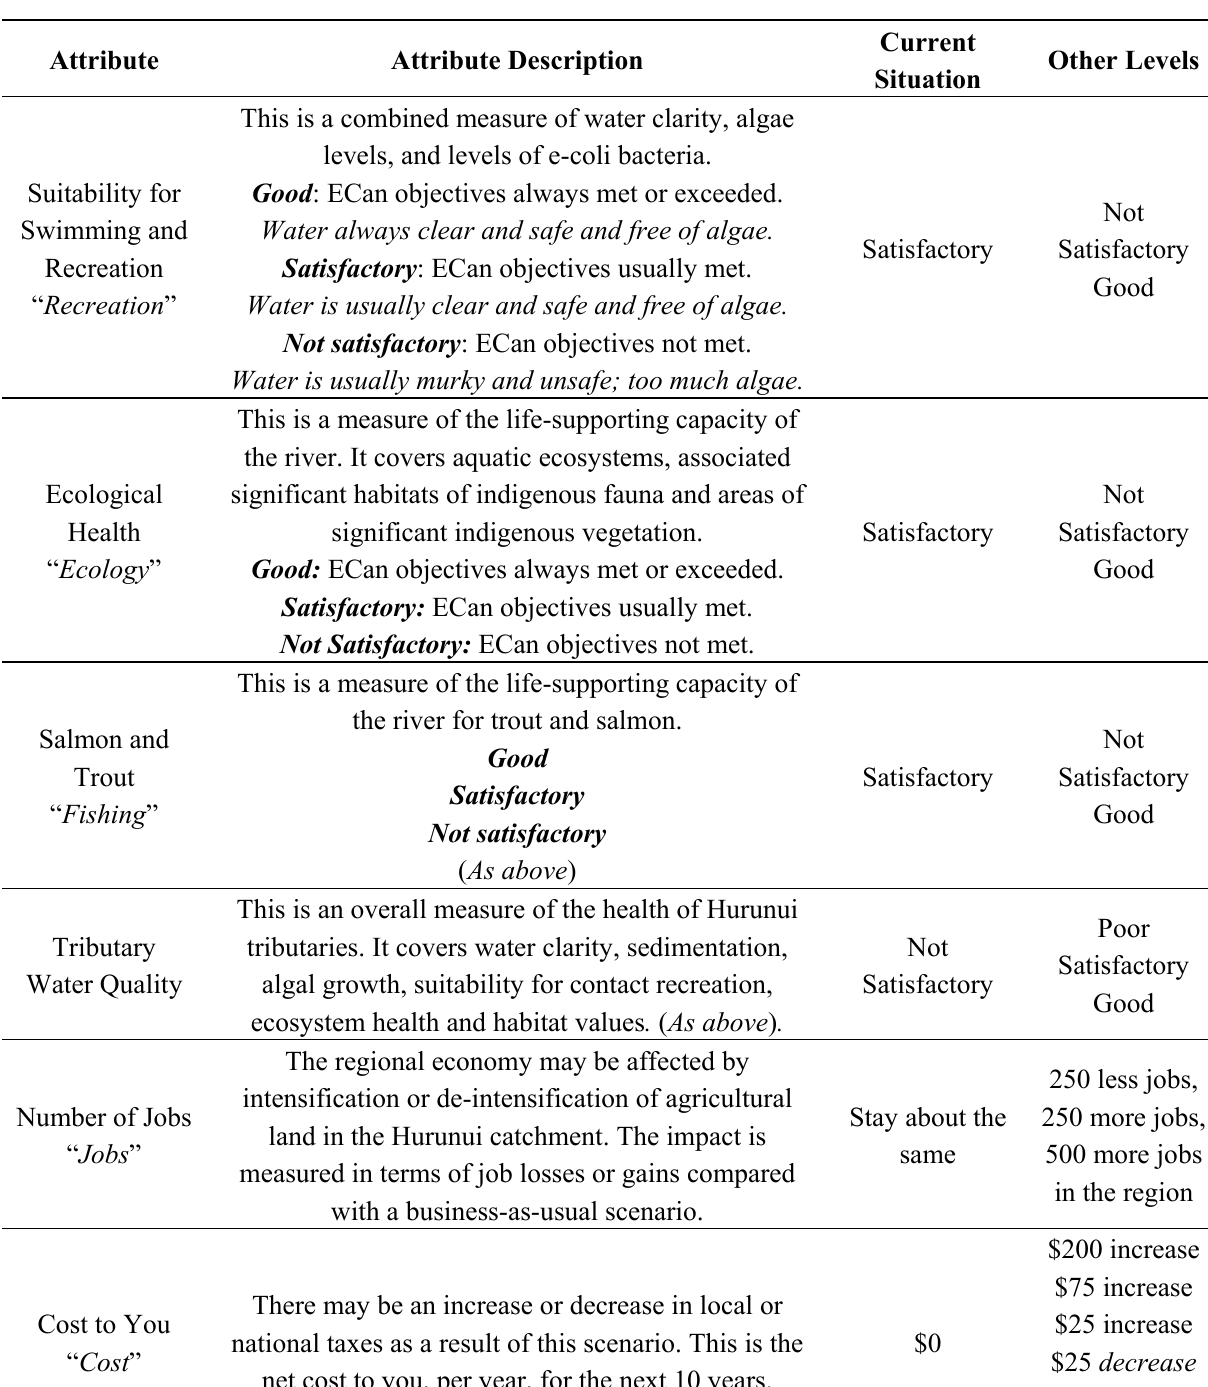
Table A2. Attribute